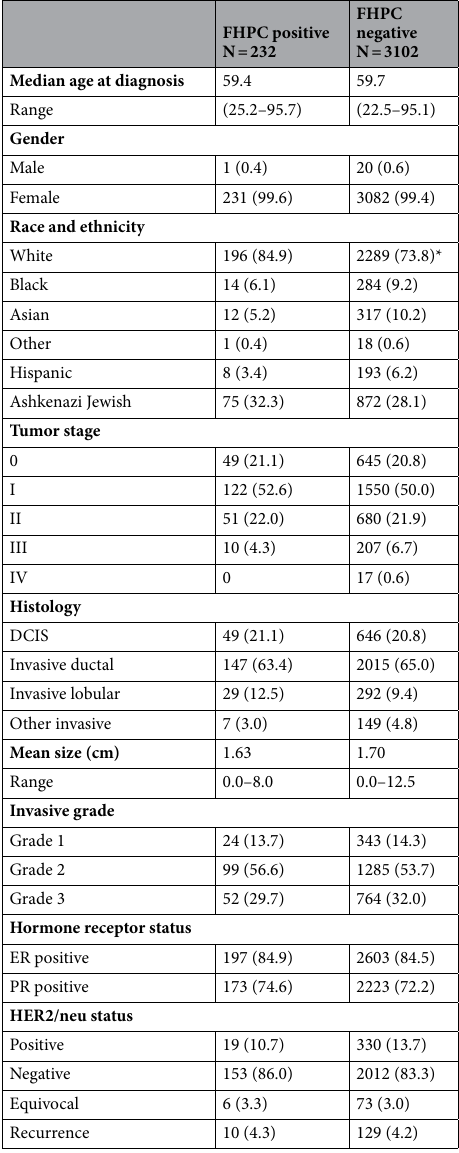
Table 1. Demographic and clinical characteristics. FHPC family history of pancreatic cancer. *p =